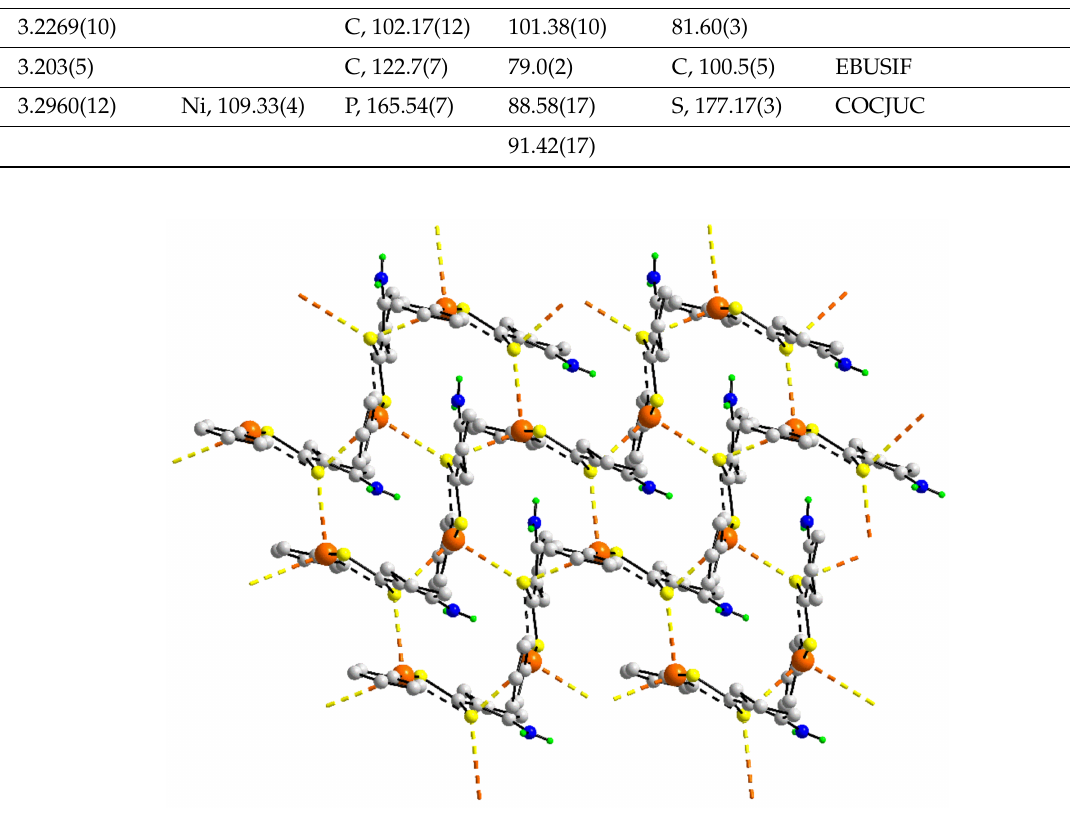
Figure 23. Supramolecular layer in the crystal of 60 , having a hexagonal pattern of Hg 3 S 3 atoms participating in inter- and intra-molecular Hg ··· S